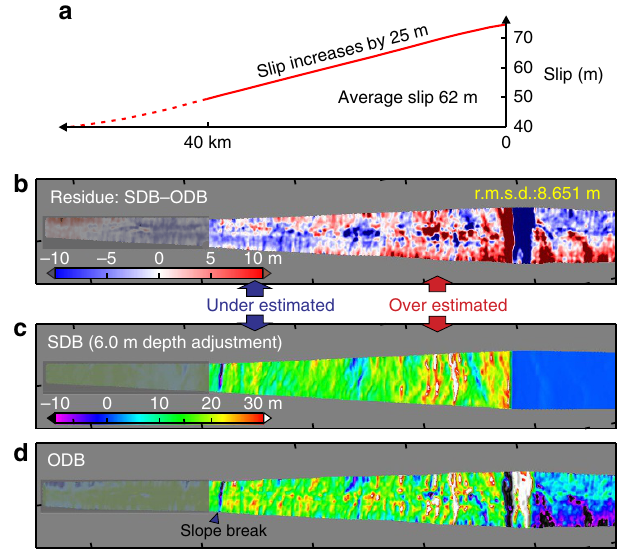
Figure 6 | Testing SDB model for the central corridor with large trenchward increase in fault slip. Otherwise the figure is similar to Fig.